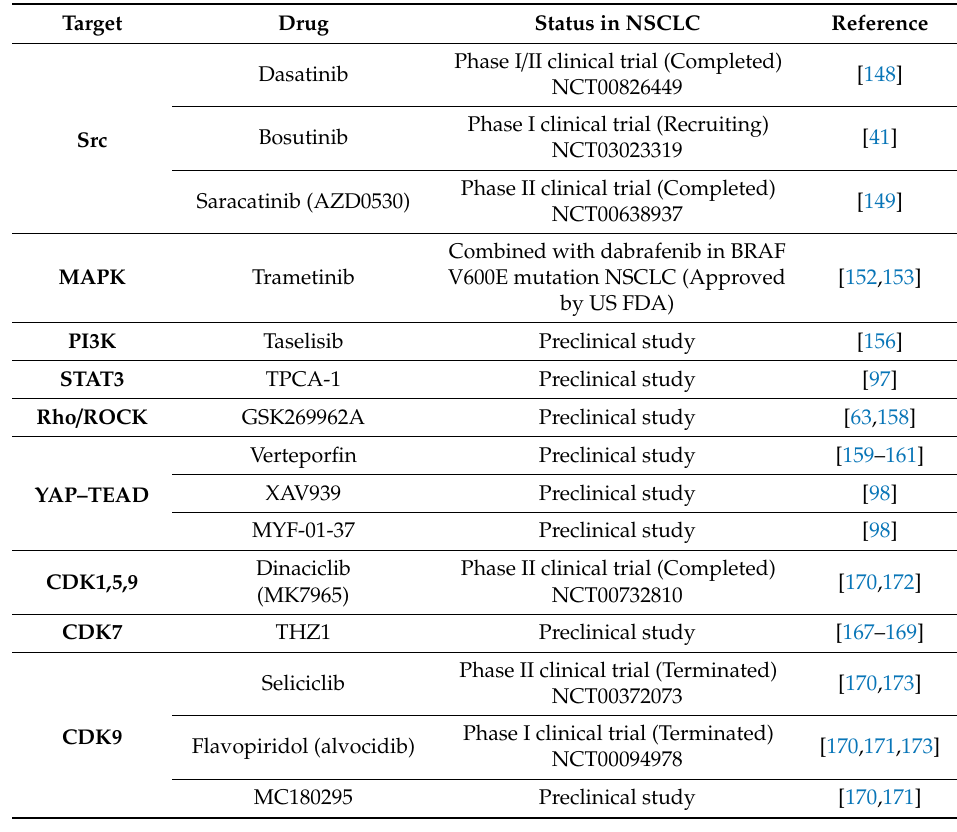
Table 3. Chemical compounds and drugs targeting the Src–YAP axis.